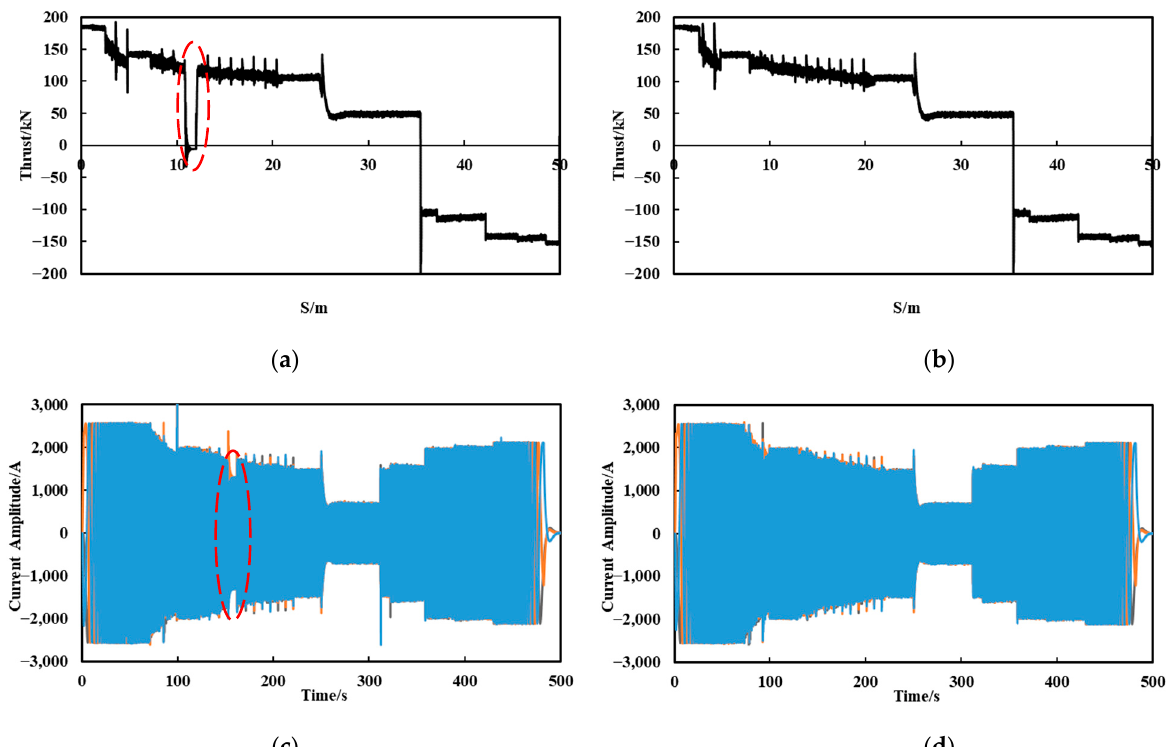
Figure 10. The current and thrust force of LLSM at two sides when the fault occurs during acceleration process: ( a ) thrust of the fault side LLSM; ( b ) thrust of the normal side LLSM; ( c ) current of the fault side stator segment; ( d ) current of the normal side stator segment. When the train passes through the fault segment during the acceleration process, the left-side LLSM is subjected to a braking force of 5.8 kN as circled in Figure 10a. The right- side converter is in the maximum output state to enable it to provide a traction force of 124 kN. As circled in Figure 11, the acceleration decreases from 0.56 m/s 2 to 0.17 m/s 2 dur- ing the process. The acceleration can return to normal after the train leaves the fault segment and enters the next normal stator segment.